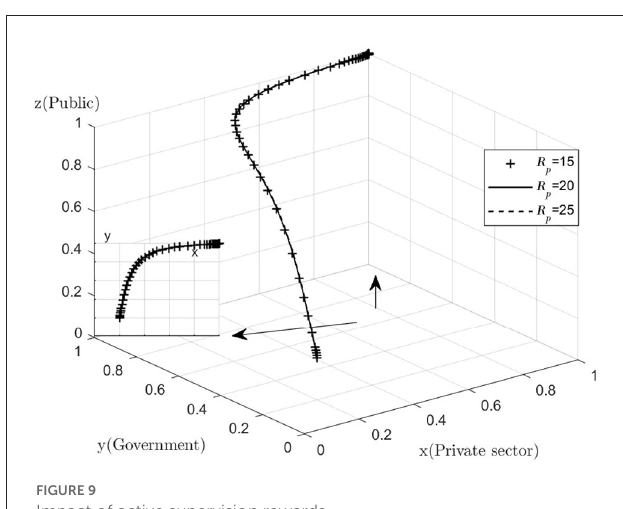
FIGURE9 Impact of active supervision